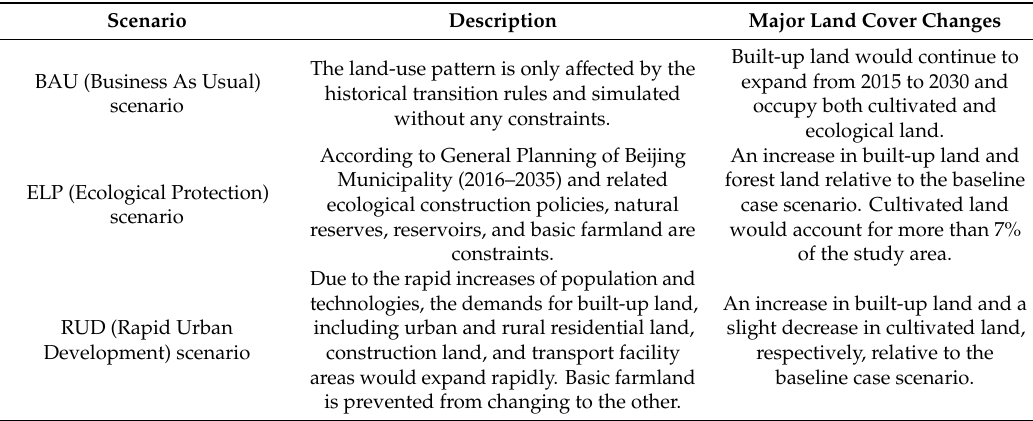
Table 2. Descriptions of alternative scenarios and their land cover